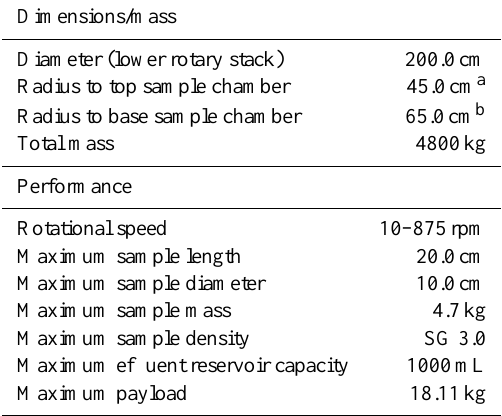
Table 1. Specifications and performance details of the Broad- bent GT-18 centrifuge permeameter (CP) system as constructed by Broadbent